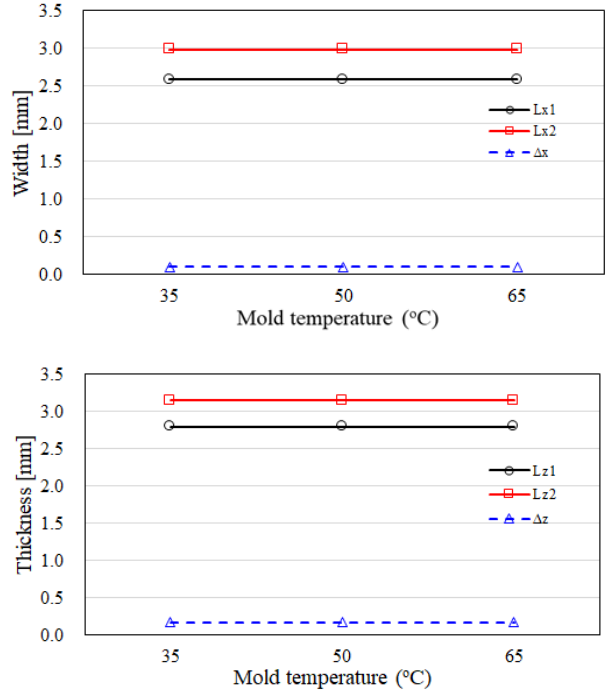
Figure 11. The dimension variation of the CSC structure for melt temperature effects.